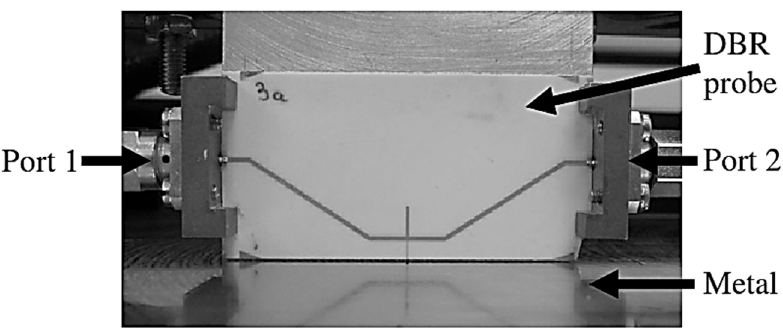
Figure 9. Photograph of the first-order DBR probe above the stainless steel plate (from [29]; copyright © 2008; adopted with permission).